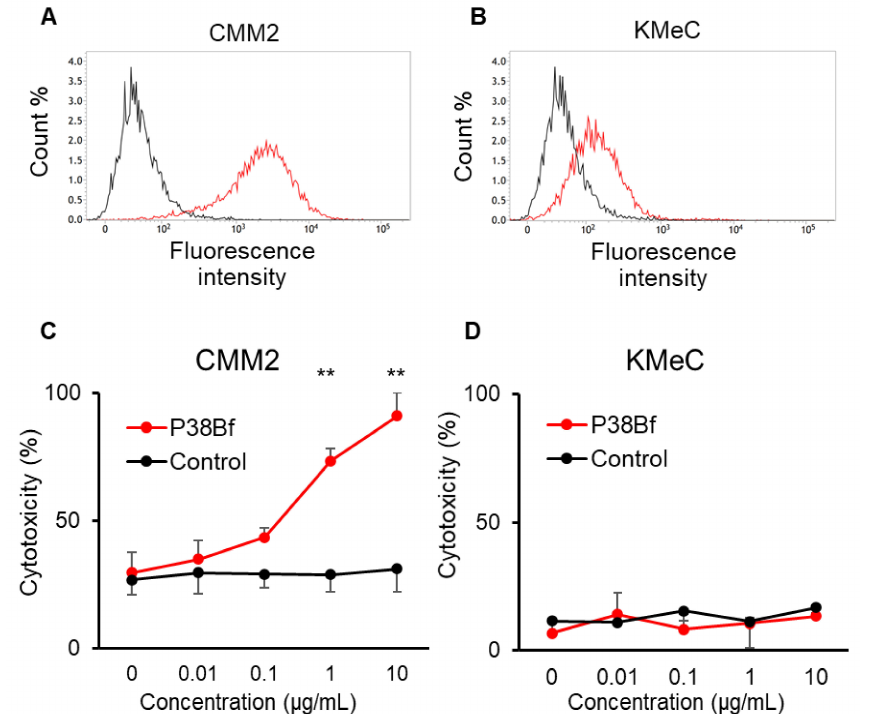
Figure 1. Flow cytometric analysis of CMM2 ( A ) and KMeC ( B ) cells treated with isotype control (black line) and a cancer-specific mouse–dog chimeric anti-PDPN antibody (P38Bf) (red line). P38Bf